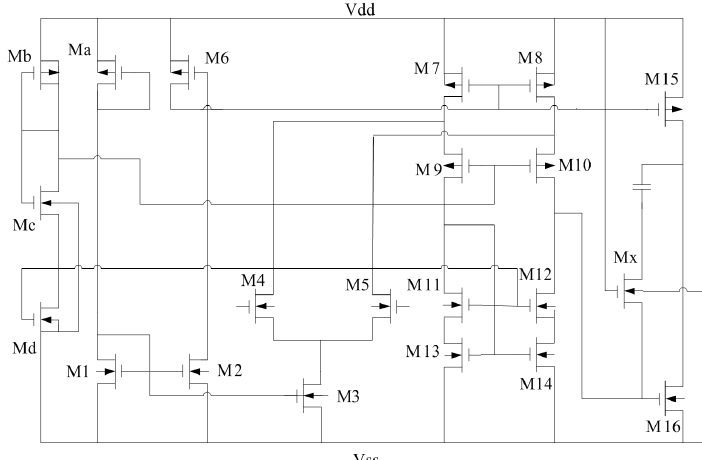
Figure 8. Design of the operational amplifier circuit.